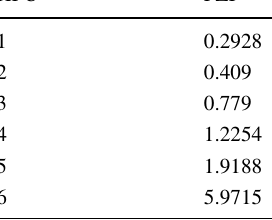
Table 1 Average values of the obtained FZI